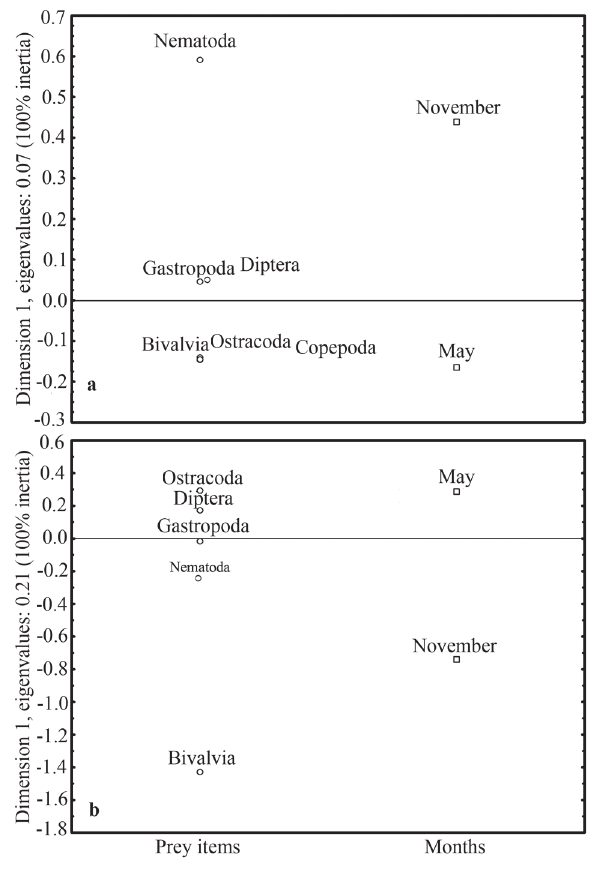
Fig. 4. Correspondence analysis between prey items (circles) and studied months (squares). ( a ) Prey items of individuals of the size class 1 ( b ) Prey items of individuals of the size class 2. Note that the analysis resolved in only one